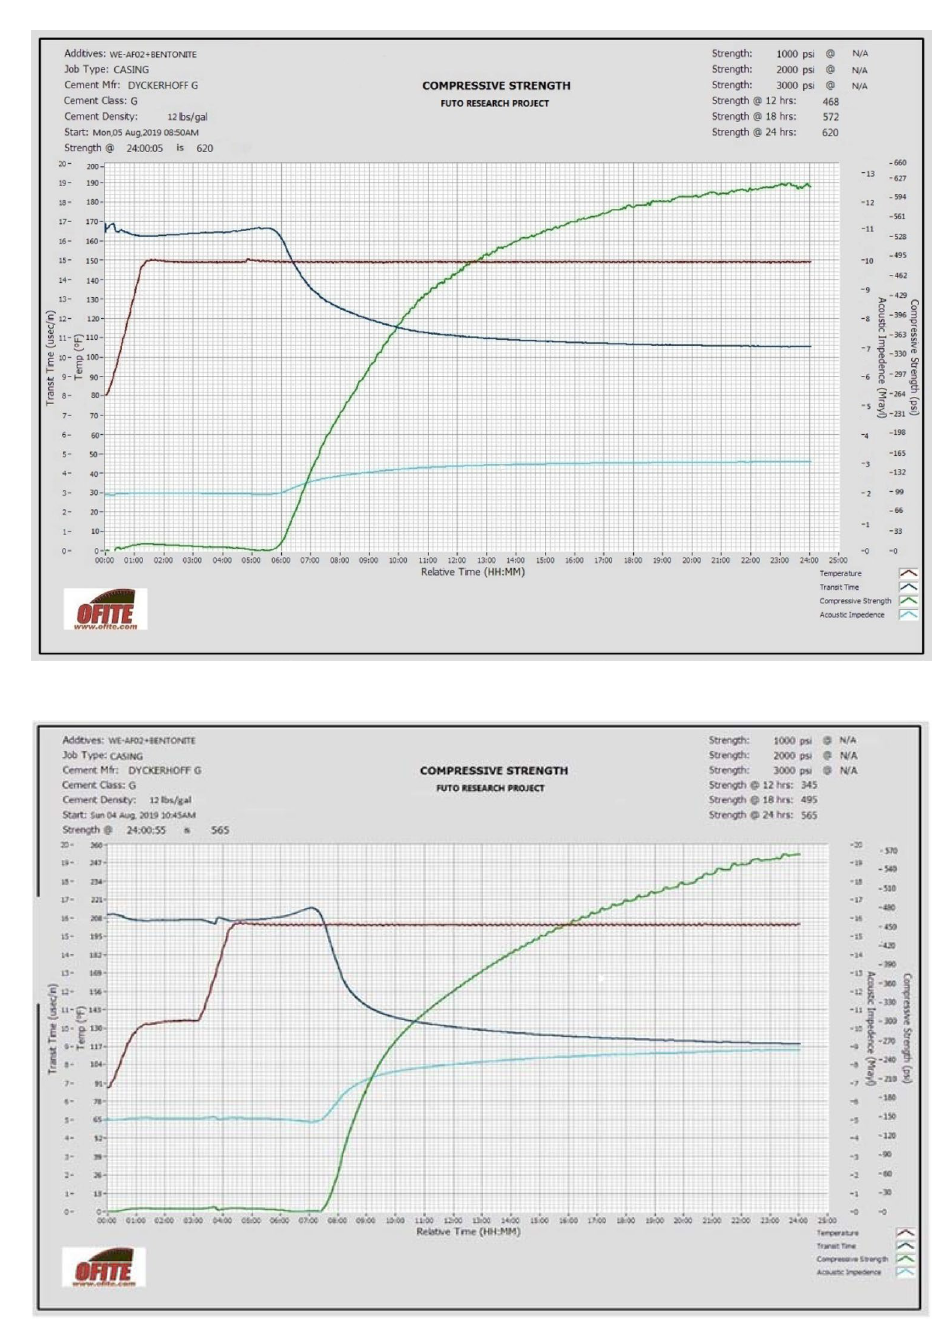
Fig. 10 Compressive strength chart for Bentonite at 150 °F (65.6 °C)